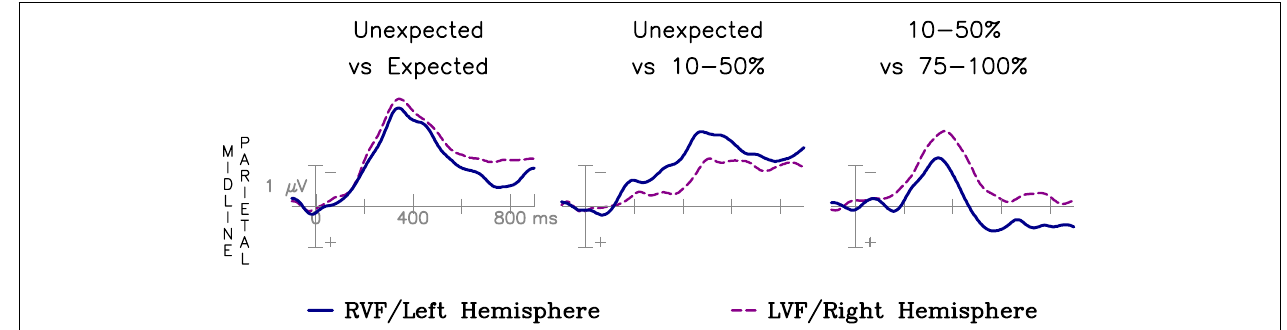
Unexpected endings andWeakly Expected endings (10–50% cloze) is larger for the RVF/LH, and the difference betweenWeakly Expected endings and Strongly Expected endings (75–100% cloze) is larger for the